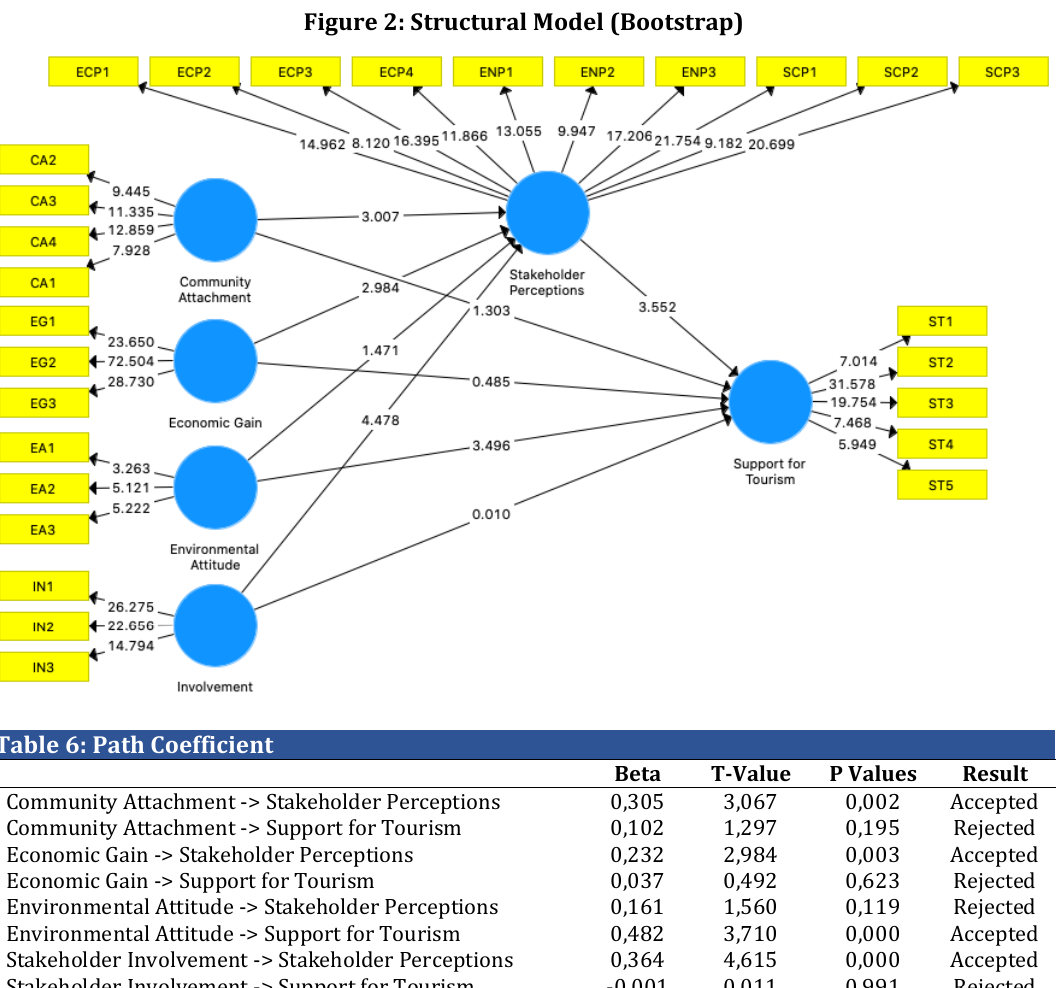
Figure 2: Structural Model (Bootstrap)